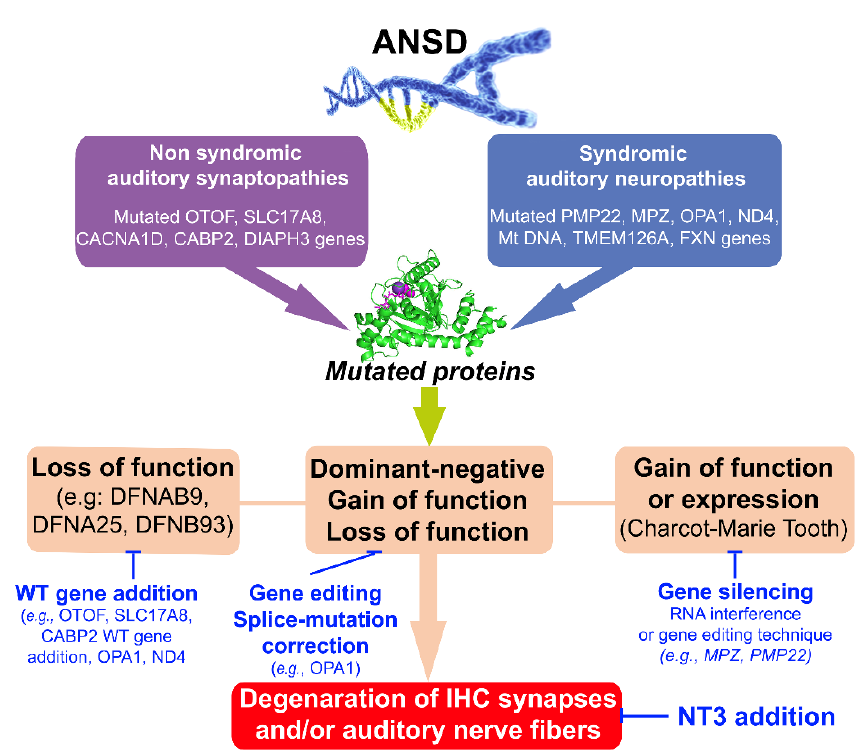
Figure 3. Summary diagram of the design gene therapies discussed in this review. Genetic syndromic auditory neuropathy affects multiple nerves, while non-syndromic auditory synaptopathy is limited to IHC ribbon synapses. These auditory phenotypes may result from loss of function, dominant negative effects, or gain-of-function expression mechanisms. Hearing rescue strategies may be designed to target the different levels of disease mechanisms, i.e., (i) WT gene addition to rescue loss function phenotype; (ii) gene or mRNA editing to correct dominant-negative, gain-of-function, or loss of function mutations; (iii) gene silencing to correct gain-of-function or expression; and (iv) NT3 gene or protein addition to enhance the repair and/or regeneration of auditory synapses and nerve fibers. The mutated protein shown here is the OPA1 protein involved in dominant optic atrophy (DOA).